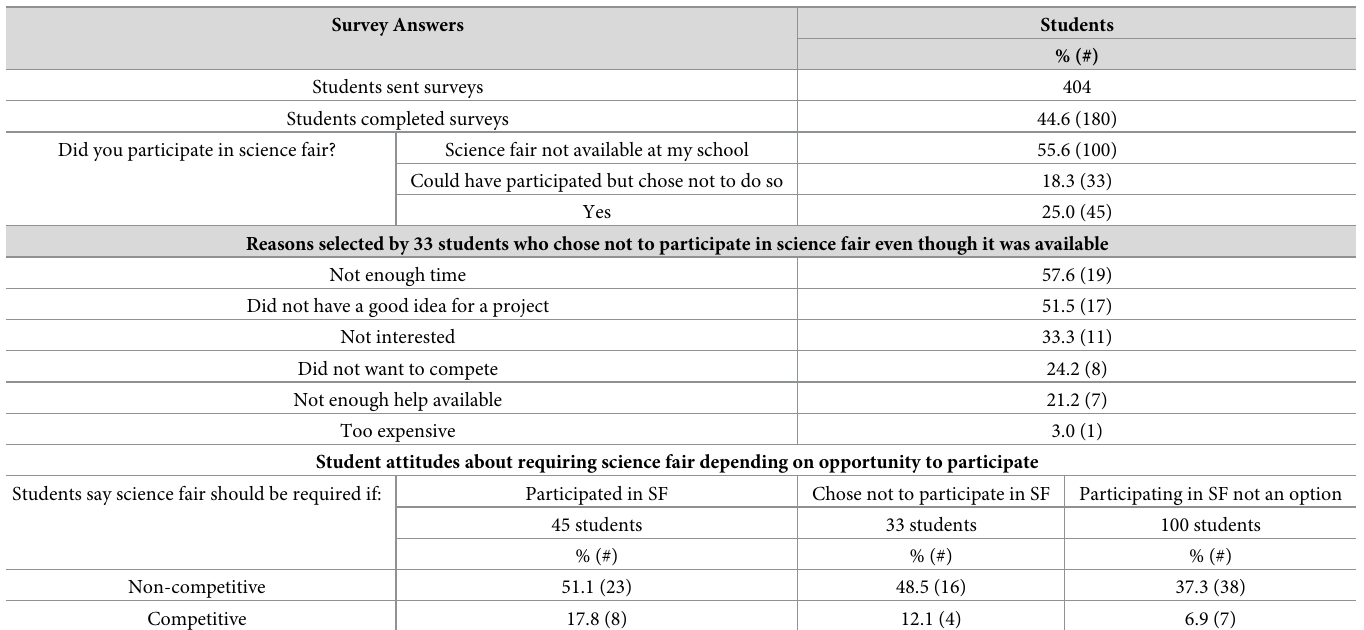
Table 5. Availability of high school science fair to SURF students and reasons not to participate.